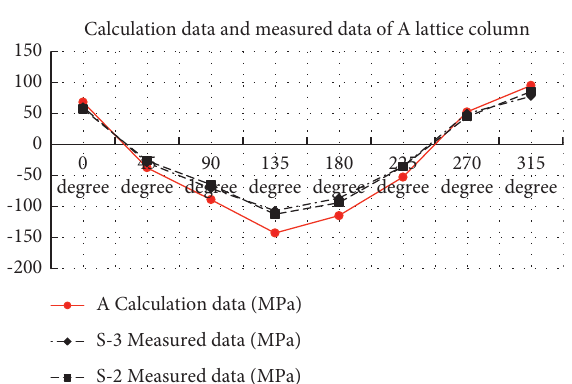
Figure 13: Comparison chart of calculated stress and measured stress of A lattice